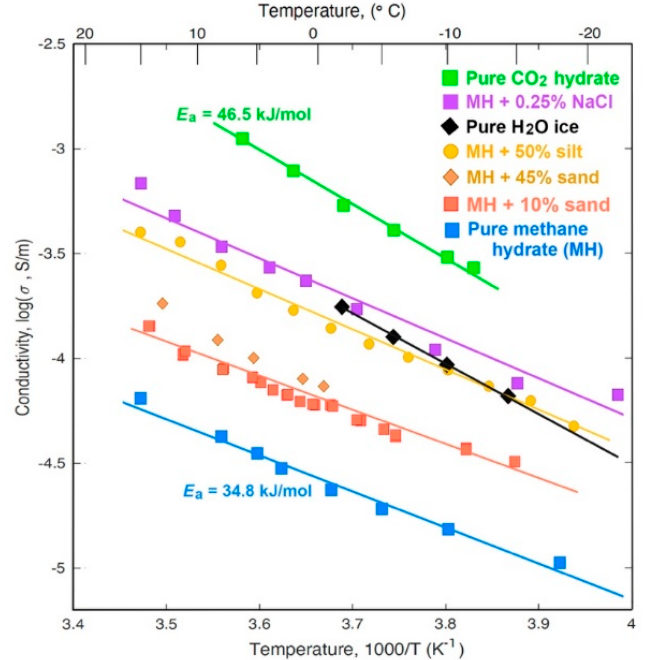
Figure 6. Electrical conductivity ( σ ) versus reciprocal temperature for pure CO 2 hydrate compared with pure H 2 O ice, pure methane (CH 4 ) hydrate, CH 4 hydrate doped with 0.25 wt% NaCl (the near-maximum impurity content in CH 4 hydrate without formation of a discrete saline fluid phase), and CH 4 hydrate containing 10, 45, and 50 vol.% of quartz sand or silt. Modified from data reported in [84–88]. CO 2 hydrate exhibits measurably higher conductivity than all methane-hydrate-bearing samples tested here, including those with varying ionic impurity contents. Unlike pure CH 4 hydrate, CO 2 hydrate is also more conductive than ice.